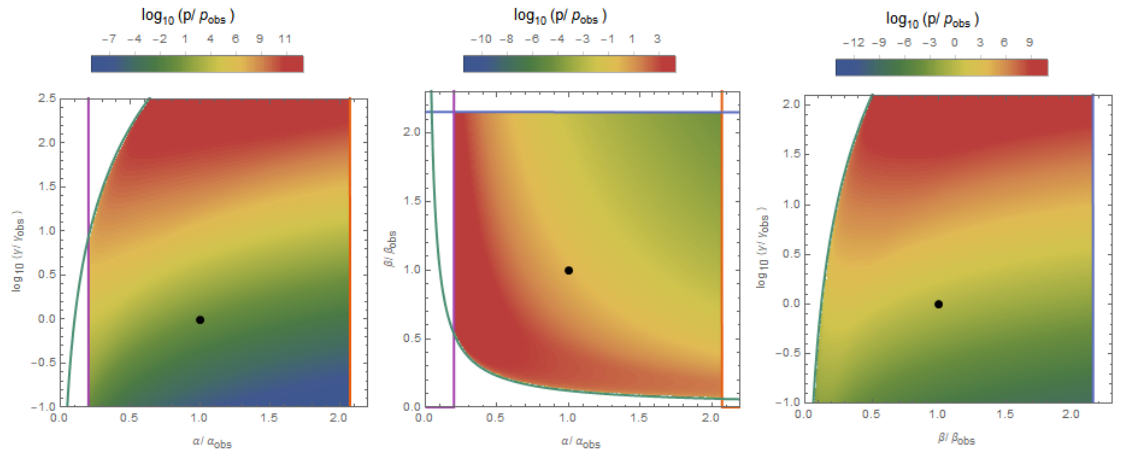
Figure 4. Distribution of observers from imposing the photosynthesis condition. A strong preference for the parameters to be restricted to the photosynthetic range is introduced, but there is still a preference for large γ